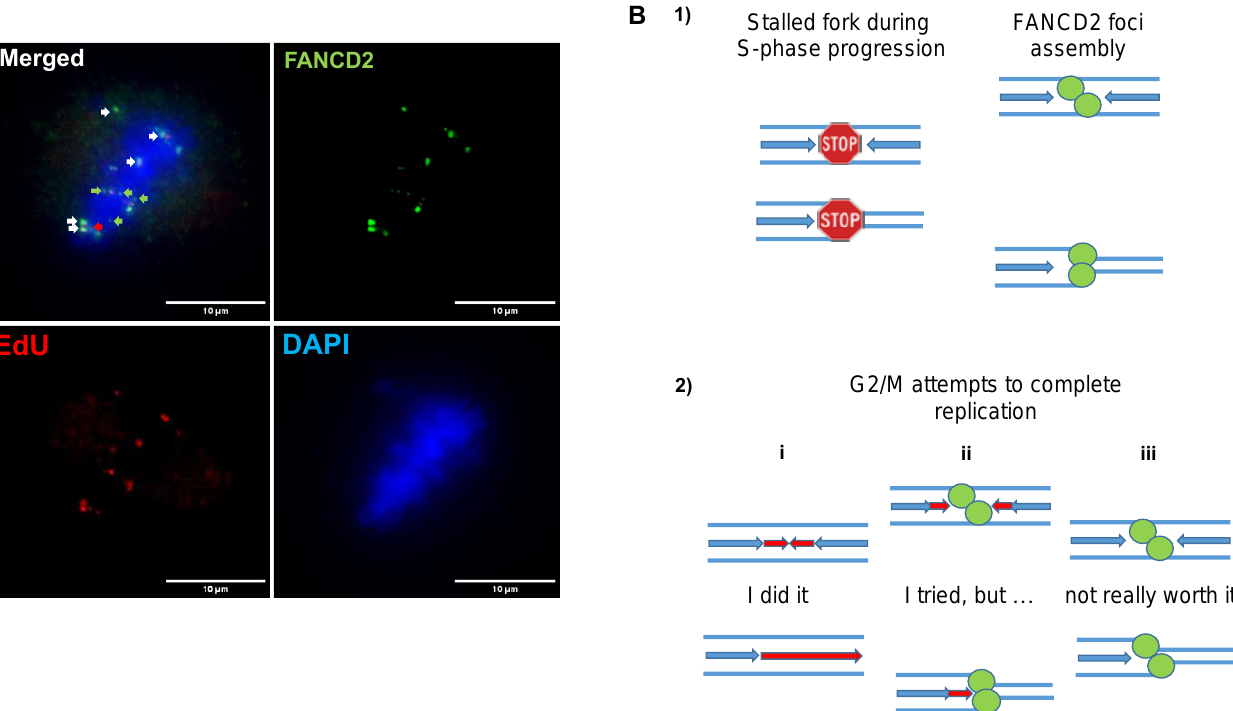
Figure 5. Colocalization of FANCD2 foci with EdU on mitotic cells. Colocalization of FANCD2 foci with EdU spots on mitotic cells. ( A ) APH-treated HeLa cells display FANCD2 foci (in green) that extensively colocalize (white arrow) with EdU spots (red). However, in some cases, FANCD2 foci (green arrows) as well as EdU spots (red arrow) exist as isolated signals. ( B ) (1) During replication stress, a single or two convergent forks are blocked, inducing the recruitment of FANCD2 twin foci to chromatin on both DNA templates (green foci) in S phase. (2) (i) During the next G2/M, under-replicated FANCD2-related regions synthesize DNA (red arrows) completing DNA replication and FANCD2 foci are eliminated, explaining the presence of single EdU foci. (ii) In the second scenario, replication cannot be totally completed. Thsu, FANCD2 foci persist colocalizing with EdU spots (red arrows and green foci). (iii) The third scenario is based on the persistence of FANCD2 foci in the absence of EdU involving an aborted DNA synthesis in G2/M (scale bar = 10 µm).